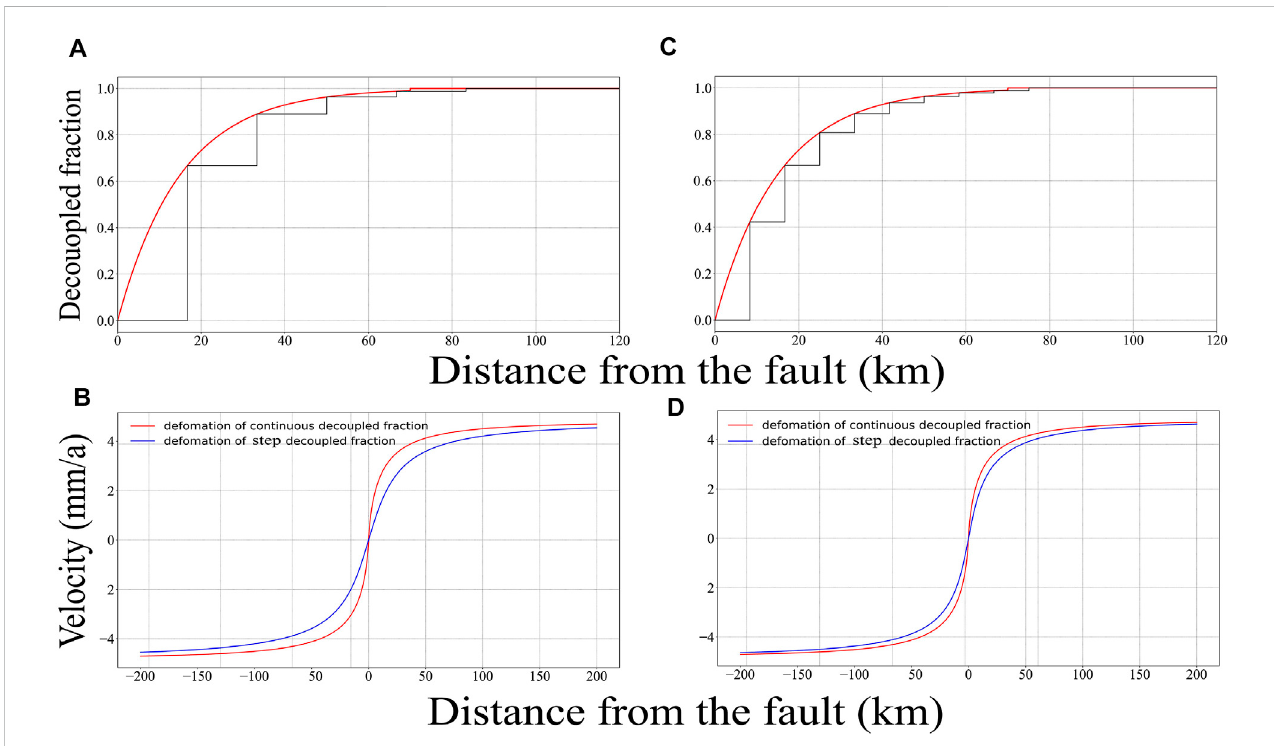
FIGURE 8 Deformation of step θ ( l ) approaching continuous θ ( l ) . (A,C) Step θ ( l ) (black line) approaching continuous θ ( l ) (red line) with different steps. (B,D) corresponding deformation. Red and blue lines are based on continuous θ ( l ) and step θ ( l ) ,